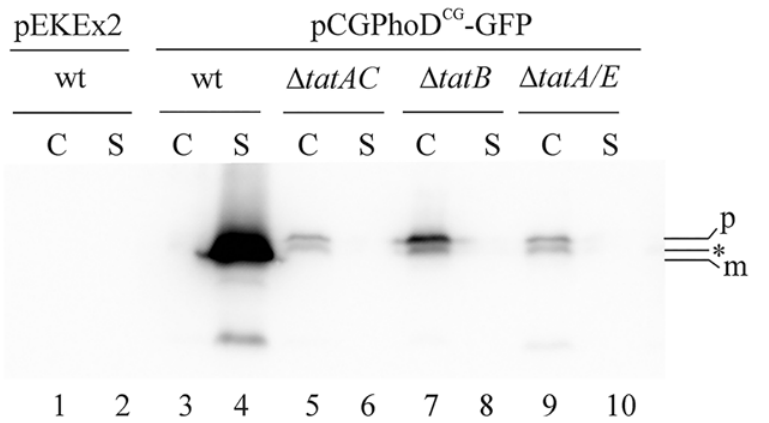
Fig 3. Analysis of PhoD CG -GFP secretion in C . glutamicum wild-type and tat mutant strains. Cultures of C . glutamicum strains expressing the Tat-dependent PhoD CG -GFP model protein [35] were fractionated into cells (C) and supernatant (S). Samples of the fractions corresponding to an equal number of cells (i.e. an OD 600 of 1.0) were subjected to SDS-PAGE and immunoblotting using GFP-specific antibodies. The following strains were analyzed: C . glutamicum wild-type (wt) containing the empty vector pEKEx2 as negative control (lanes 1 and 2), C . glutamicum wild-type (wt) containing plasmid pCGPhoD CG -GFP (lanes 3 and 4), and the pCGPhoD CG -GFP-containing C . glutamicum mutant strains Δ tatAC (lanes 5 and 6), Δ tatB (lanes 7 and 8), and Δ tatA/E (lanes 9 and 10). p: PhoD CG -GFP precursor; asterisk: cytosolic degradation product; m: mature-sized GFP